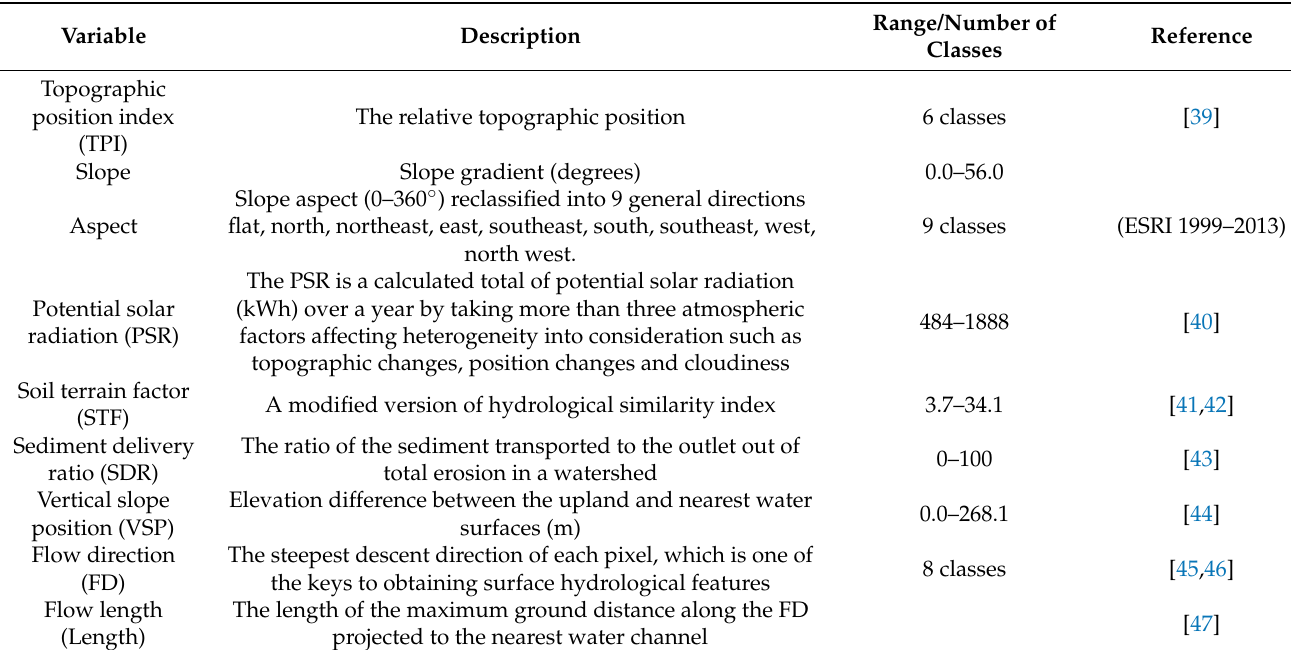
Table 1. DEM-derived topo-hydrologic variables